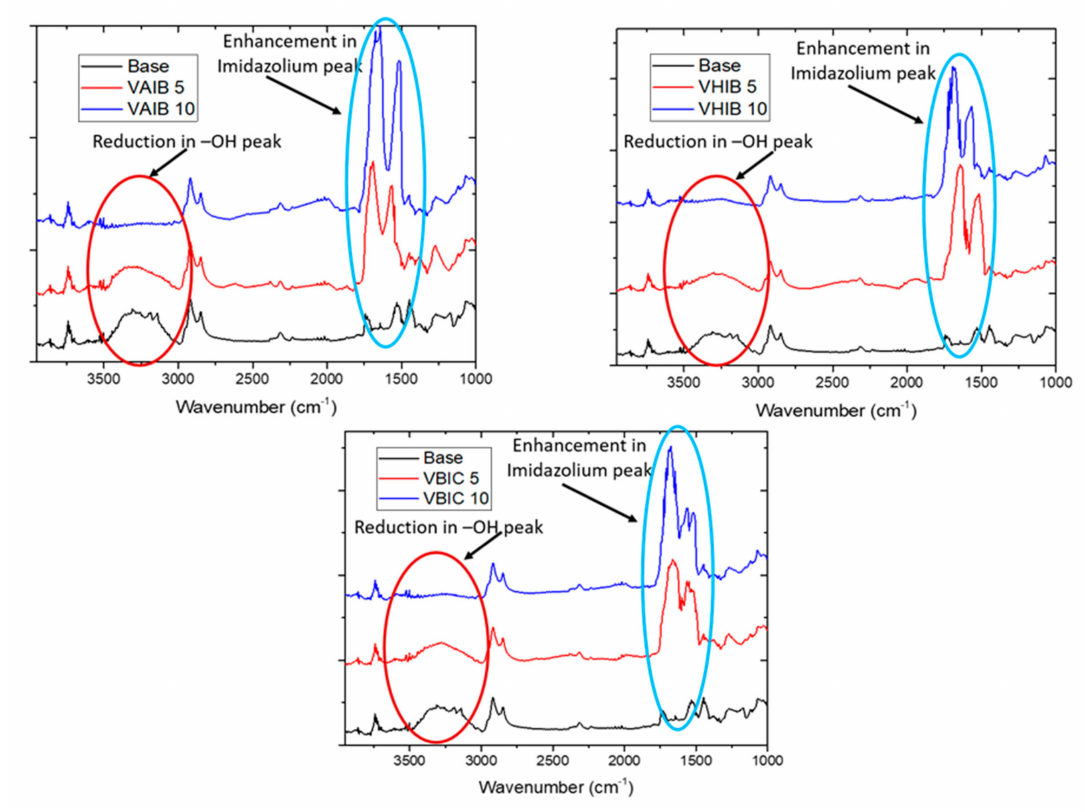
Figure 3. FTIR Spectra for base and modified